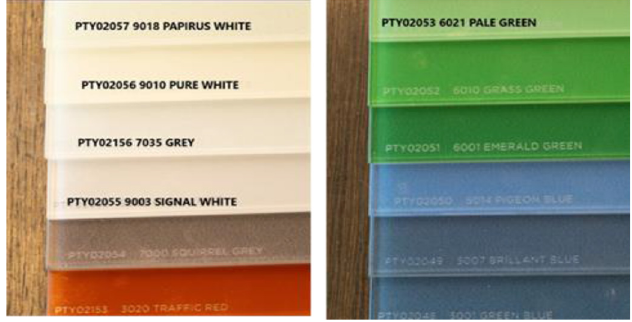
Fig. 1. The colored coating RAL of the measured